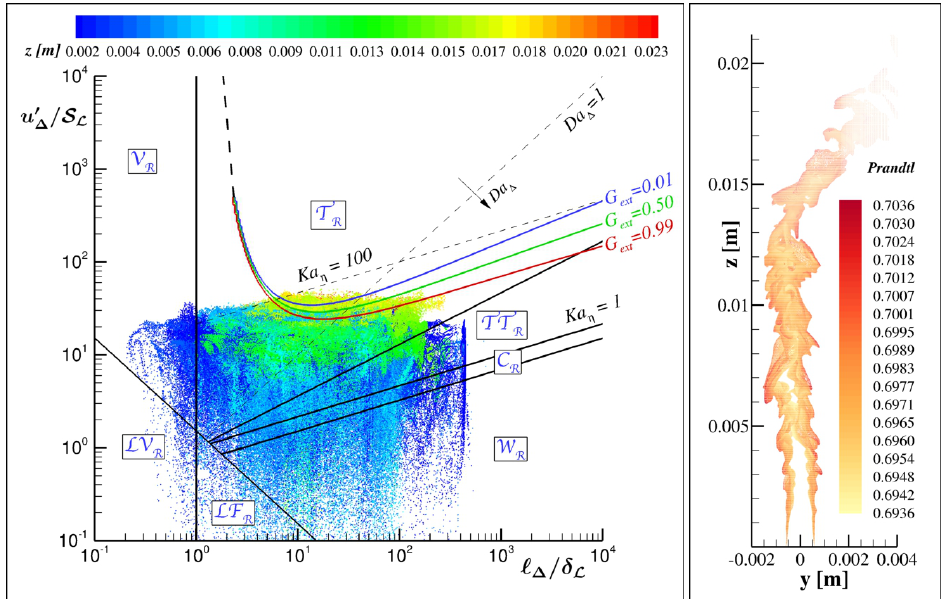
Figure 7. Instantaneous actual combustion regimes in the LTSM framework experienced by the CH 4 /H 2 /Air (20/80 by volume) premixed flame at 1 bar [47]. The interrogated points projected onto a yz plane are shown on the right. The Prandtl number distribution of these points is very tight and close to 0.7: this value was used to draw the boundaries of the L aminar and W rinkled R egimes .